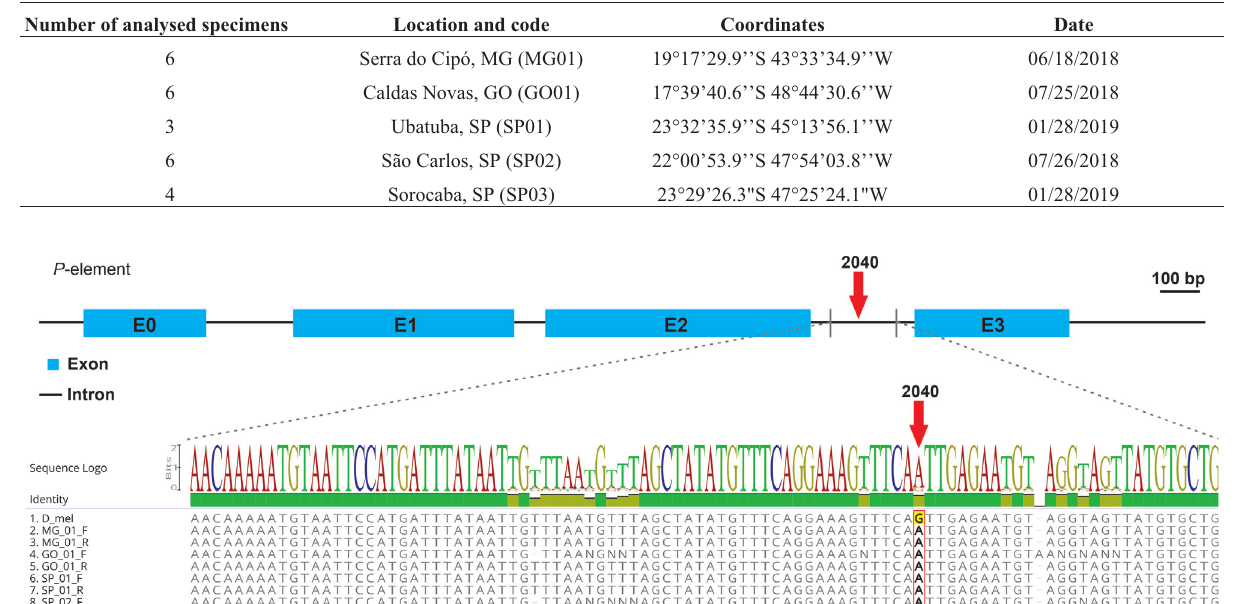
Table 1 - Brazilian Drosophila simulans populations analysed for P -element presence.